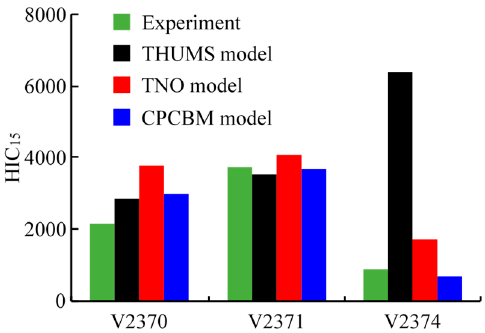
Figure 8. Head injury criterion 15 (HIC 15 ) recorded in the experiment and obtained from different human models in the simulation.